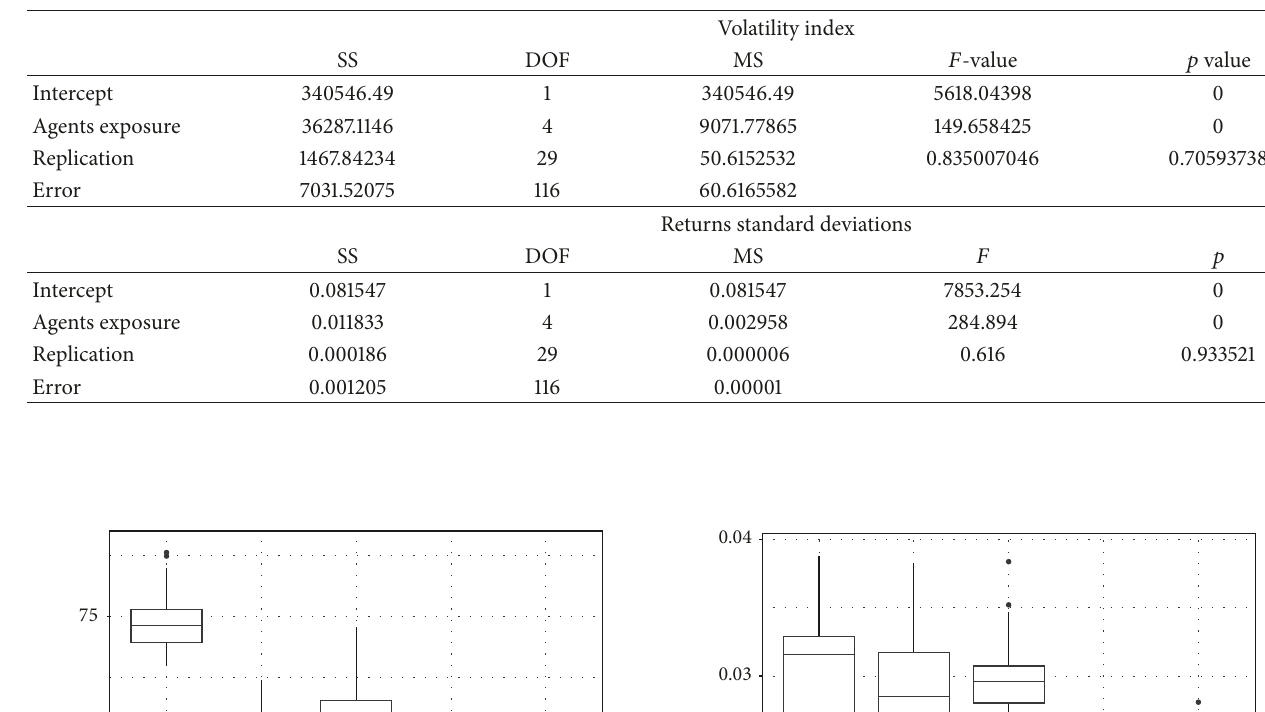
Table 4: ANOVA table.